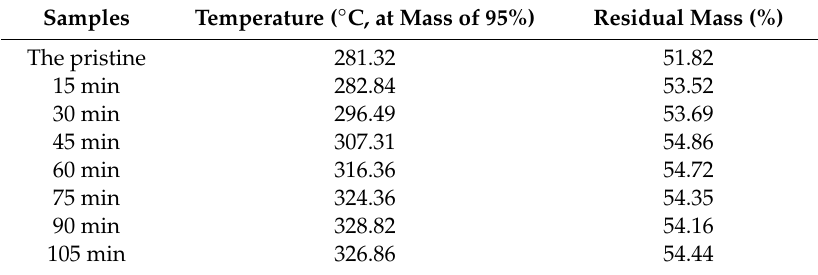
Table 2. The initial decomposition temperature and residual mass of the pristine and treated F-III fibers in Sc-CO 2